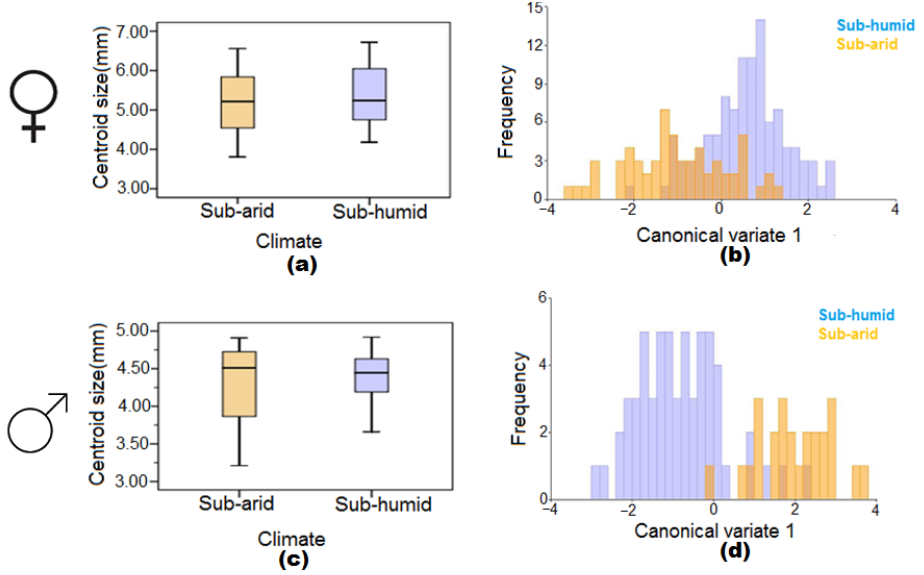
Figure 4. Boxplots of wing centroid size and wing shape diagram of the first canonical variable between sub-humid and sub-arid climatic conditions in female ( a , b ) and male ( c , d ) Cs. longiareolata mosquitoes.